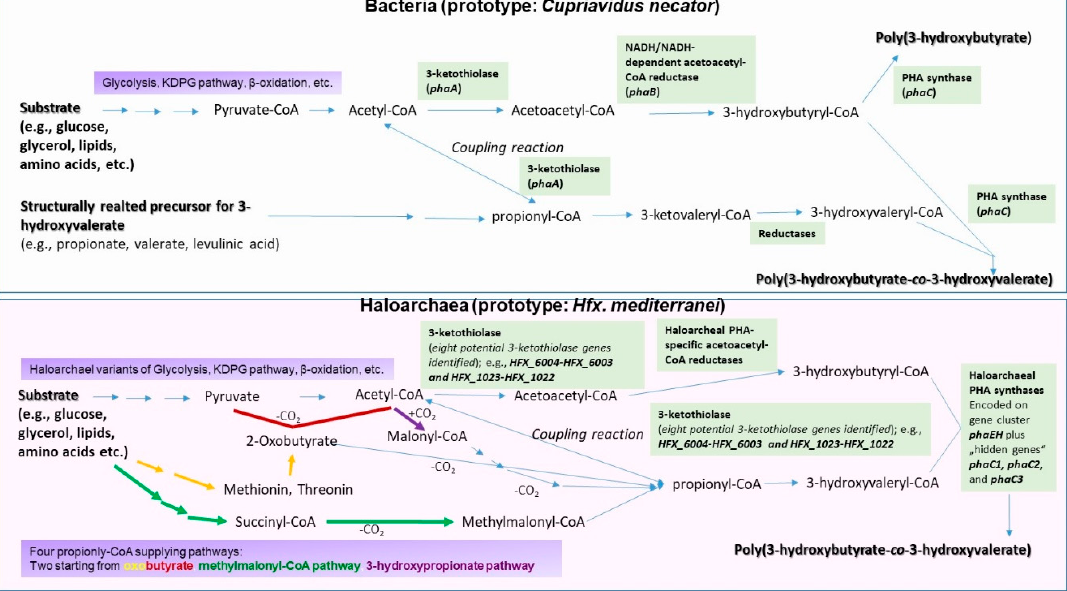
Figure 2. Simplified illustration of PHB and PHBHV biosynthesis by eubacteria (upper part, in grey; prototype organism: C. necator ) and haloarchaea (lower part, in pink; prototype: Hfx. mediterranei ). Enzymes and genes (in italics) involved in the PHA biosynthesis steps (starting from acetyl-CoA and propionyl-CoA) are in green text boxes. Special emphasis is dedicated to the propionyl-CoA supplying pathways in haloarchaea: Propionyl-CoA is generated (a) beginning with the coupling of pyruvate and acetyl-CoA, and the decarboxylation of 2-oxobutyrate (marked in brown), (b) starting from the conversion of the amino acids methionine or threonine to 2-oxobutyrate (marked in yellow), (c) starting from succinyl-CoA via methlymalonyl-CoA (marked in green), or (d) starting with carboxylation of acetyl-CoA to malonyl-CoA (marked in purple). Based on